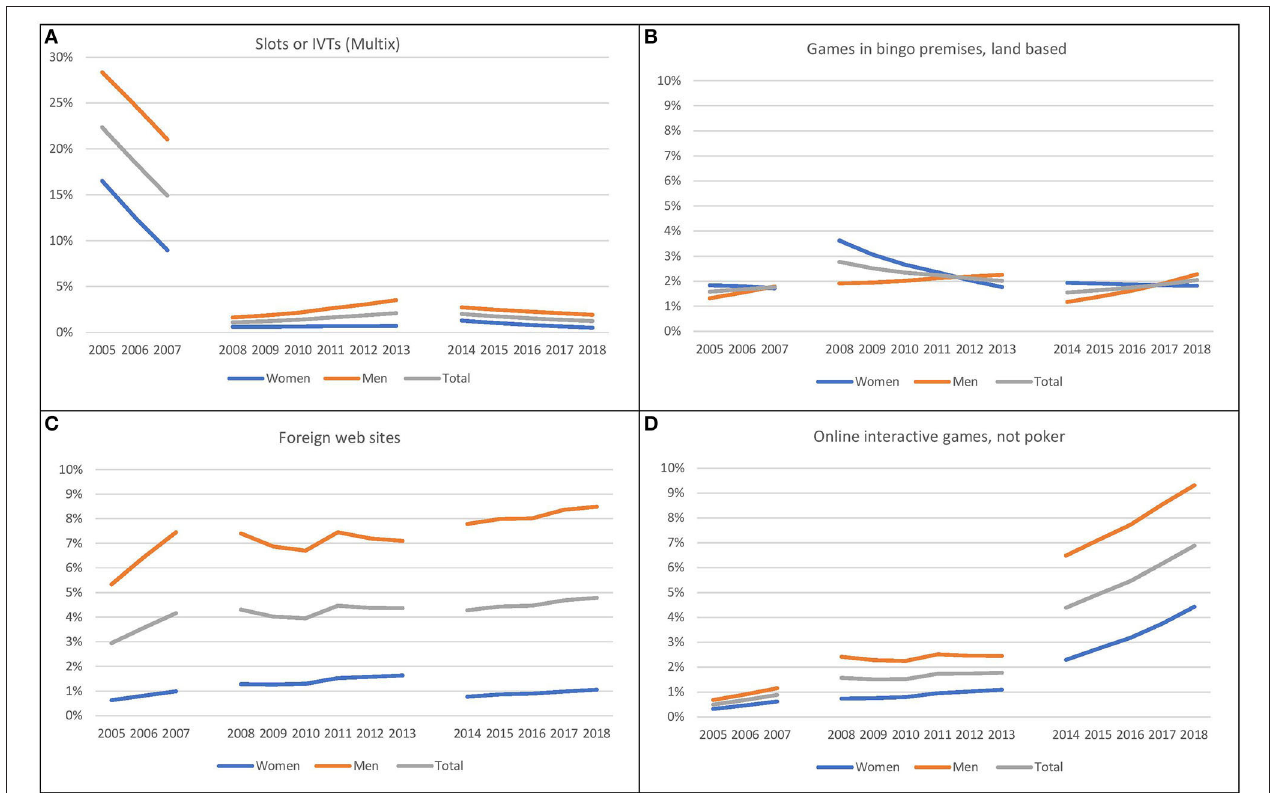
FIGURE 2 | (A–D) Predicted participation in specific groups of games ( N = 28,251). Panel (A) shows predicted participation on slot machines and IVTs (Multix), total and by gender, in three epochs (Epoch 1 from 2005 through 2007, Epoch 2 from 2008 through 2013 and Epoch 3 from 2014 through 2018). Panel (B) shows predicted participation on games in bingo premises, land-based, total and by gender, in three epochs (Epoch 1 from 2005 through 2007, Epoch 2 from 2008 through 2013 and Epoch 3 from 2014 through 2018). Panel (C) shows predicted participation on foreign websites, total and by gender, in three epochs (Epoch 1 from 2005 through 2007, Epoch 2 from 2008 through 2013 and Epoch 3 from 2014 through 2018). Panel (D) shows predicted participation in online interactive games, not poker, total and by gender, in three epochs (Epoch 1 from 2005 through 2007, Epoch 2 from 2008 through 2013 and Epoch 3 from 2014 through